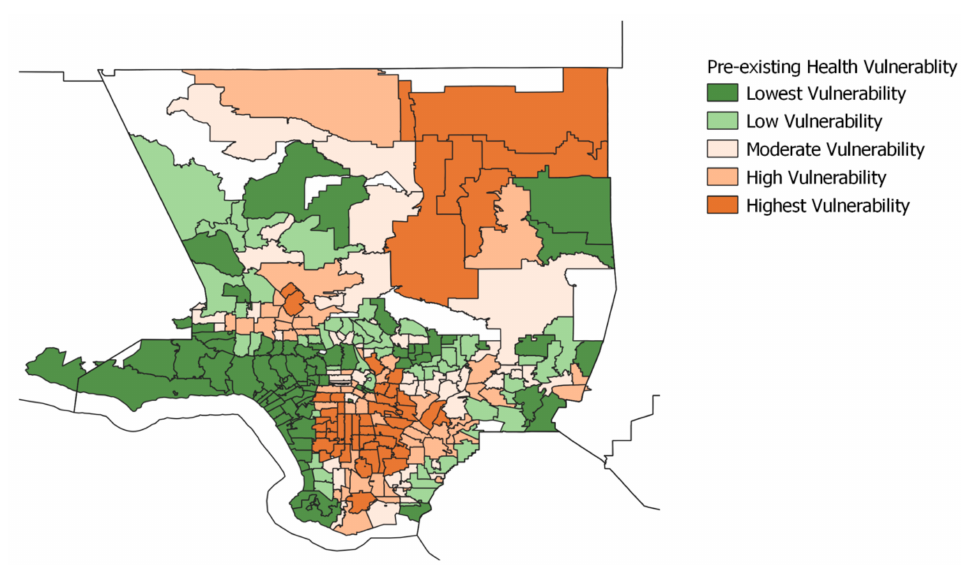
Figure 2. Pre-existing health vulnerability, Los Angeles County. This figure demonstrates the pre- existing health vulnerability in Los Angeles County, which captures the risks of COVID-19 infection and death as a result of pre-existing health conditions. These conditions include diabetes, obesity, heart disease, health status, mental health, and food insecurity. Figure 3 displays the map for the barriers to health care indicator. Neighborhoods that are in the high or highest vulnerability are located mainly in Central Los Angeles, South and Southeast L.A., as well as pockets of neighborhoods in the San Fernando and San Gabriel Valley. The neighborhoods falling within the lowest vulnerability are again located along the coast and in Northwest